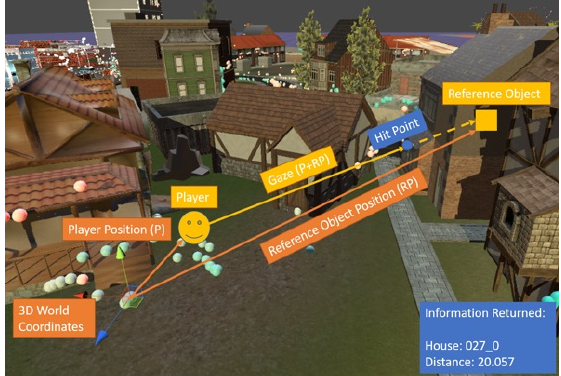
Figure 3: Ray cast (yellow) inside of Unity going from the player to the reference object. The first intersection with an object is taken as the hit point. Colored spheres visualize previous hit points of the players